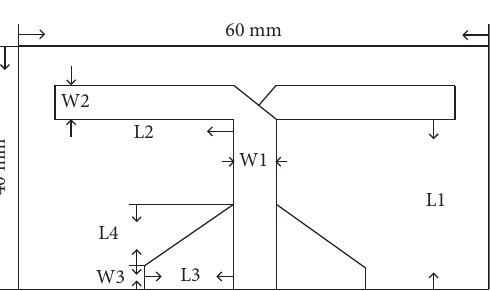
Figure 5: Structure diagram of the PDA.